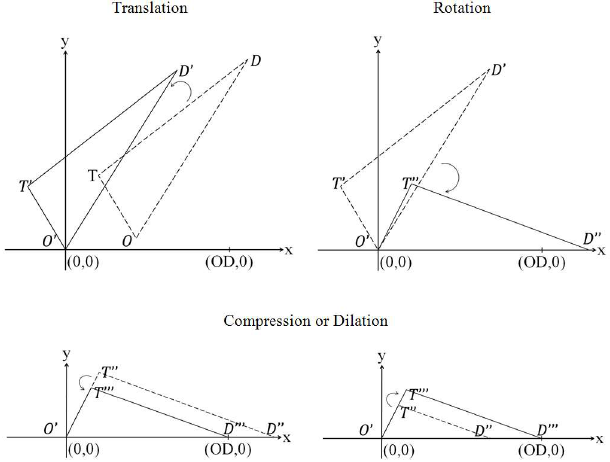
Figure 3. Euclidean transformations.